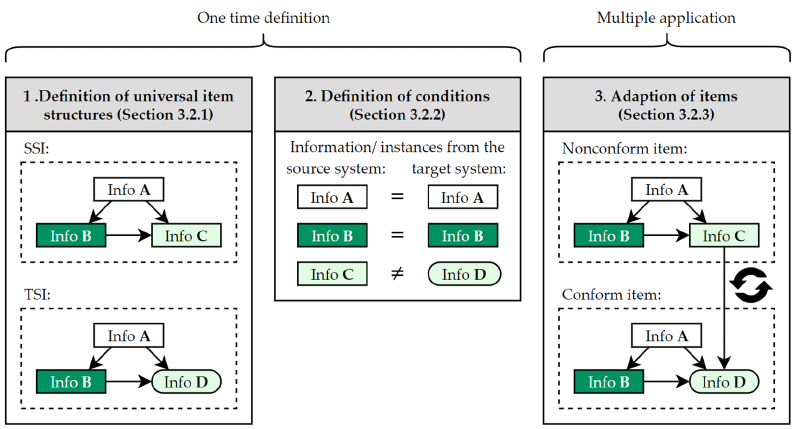
Figure 4. Schematic illustration of the compatibility improvement approach.